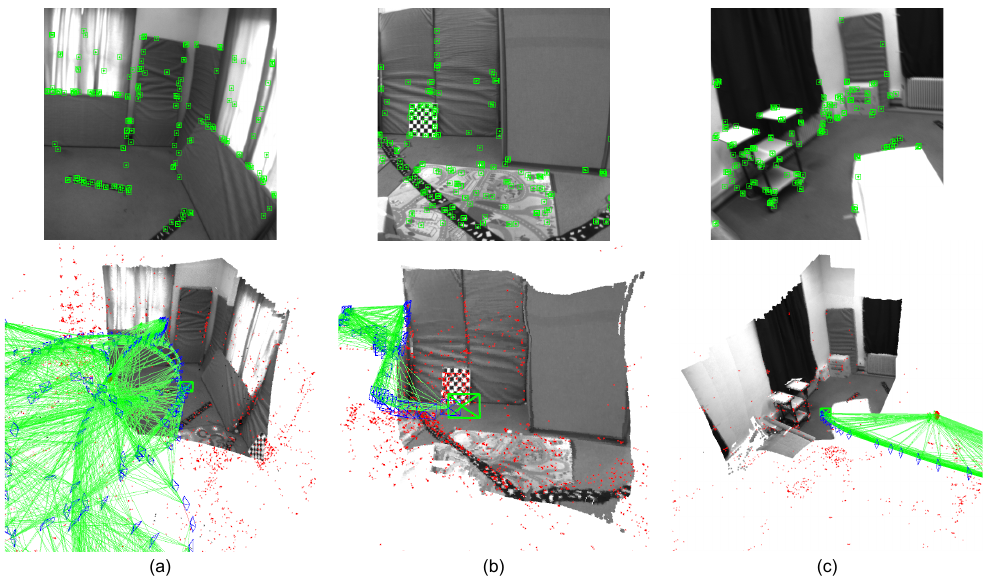
Figure 12. Demonstrations of tracking and local dense mapping on the EuRoC dataset. ( Top ): 2D feature tracking. ( Bottom ): 3D local dense mapping. ( a , b ): V1 sequences in the EuRoC dataset; ( c ): V2 sequence in the EuRoC